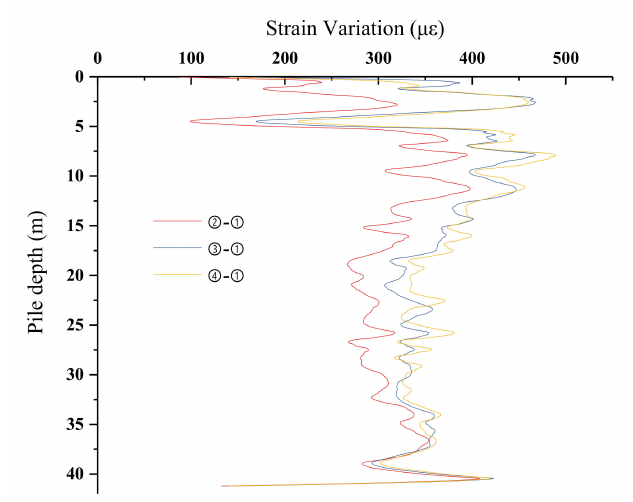
Figure 7. Strain curve of fiber sensor of one side of the pile.